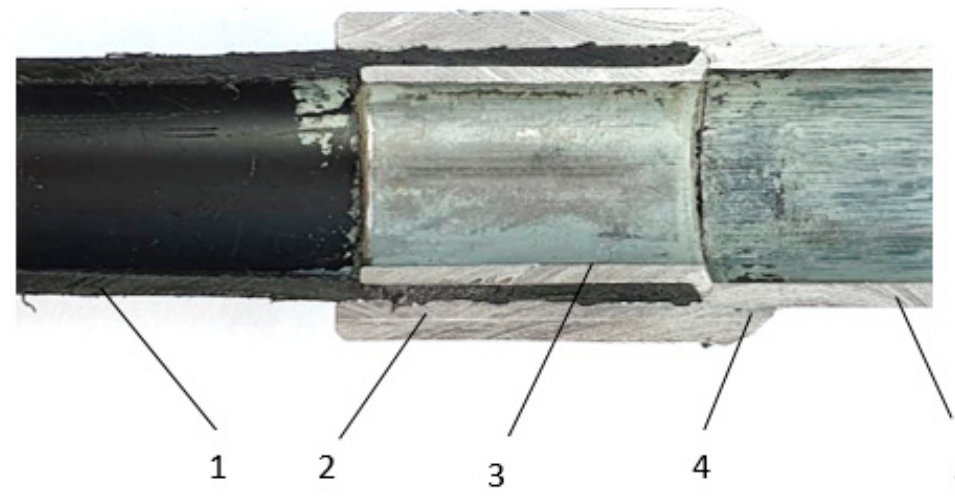
Figure 7. Section through TN transition fitting: 1—HDPE pipe; 2—outer bush; 3—inner bush; 4—welding bead; 5—steel pipe.